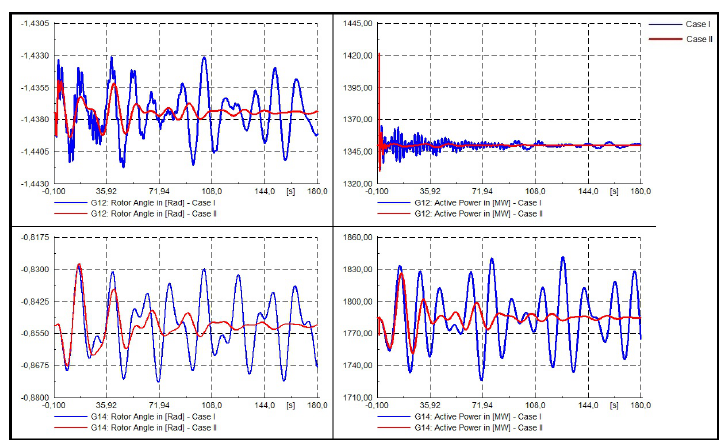
Figure 29. Rotor angle [rad] and Active Power [MW]-three phase fault at Line 18–50.